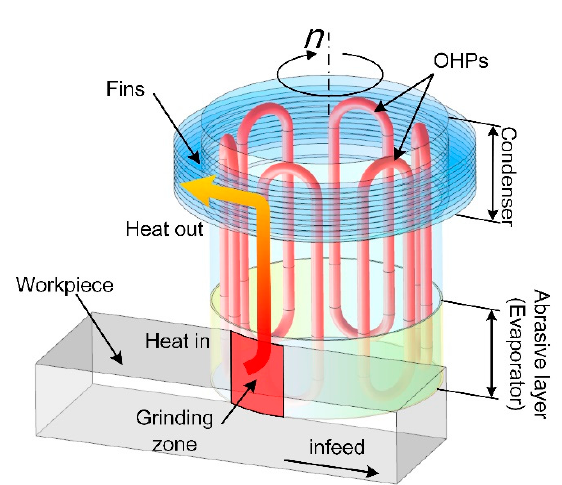
Figure 2. Simulation model illustration: grinding with the OHP grinding wheel.